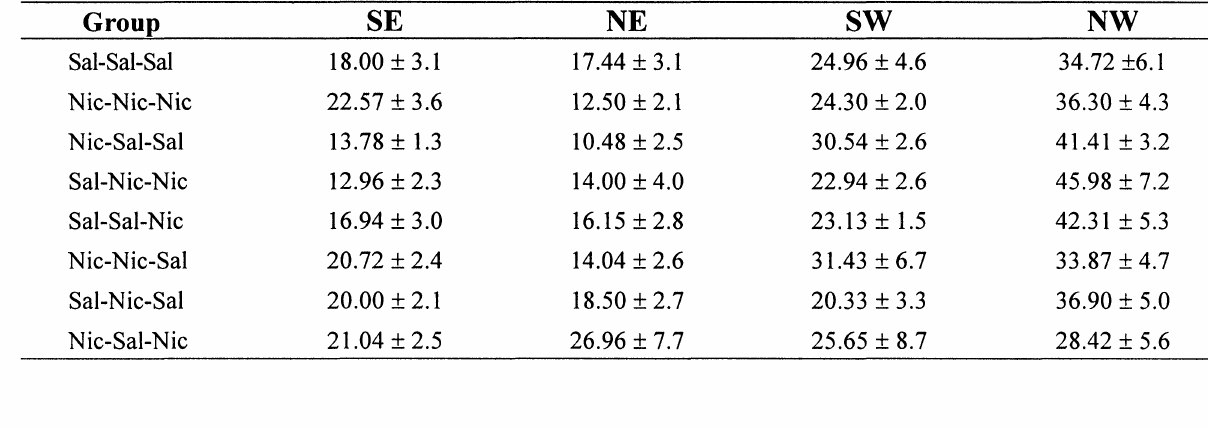
Mean Percentages Search Times in Quadrants during Probe Trial at six months of age (Test